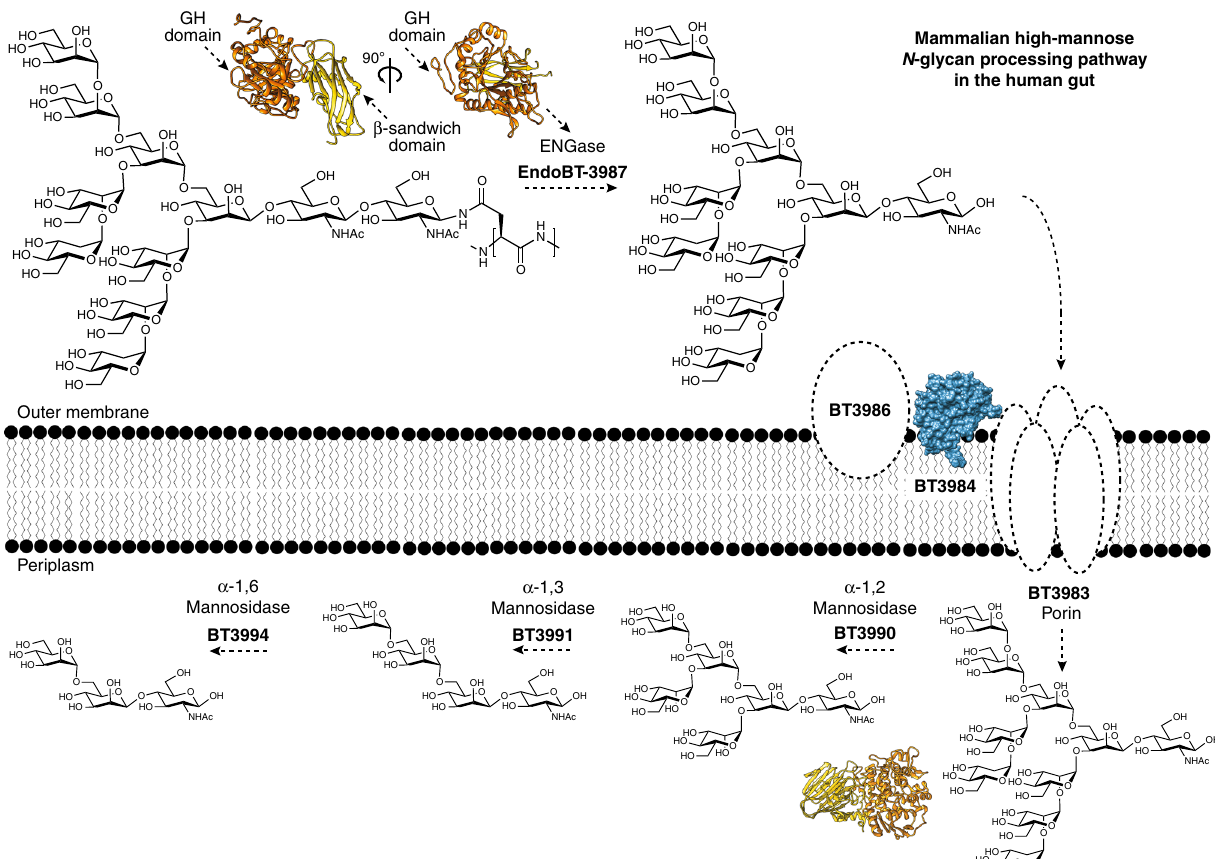
Fig. 1 Depolymerization of HM-type N -glycans by B. thetaiotaomicron . BT3987 deglycosylates HM-glycoproteins in the cell surface. The HM product interacts with the surface glycan binding protein (SGBP), BT3986, and the SusD homolog BT3984 interacts with the reducing end GlcNAc, orientating the glycan into the SusC homolog BT3983 porin. The HM glycan is transported to the periplasm where it is processed by three mannosidases to the trisaccharide Man- α -1,6-Man- β 1,4-GlcNAc. Cartoon representation of BT3987 (PDB CODE 6T8I) and BT3990 (PDB CODE 2WVZ), and surface representation of BT3984 (PDB CODE 3CGH;